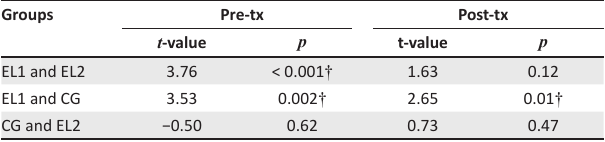
TABLE 2: Results of t -tests for significant differences between groups on word discrimination scores. Groups